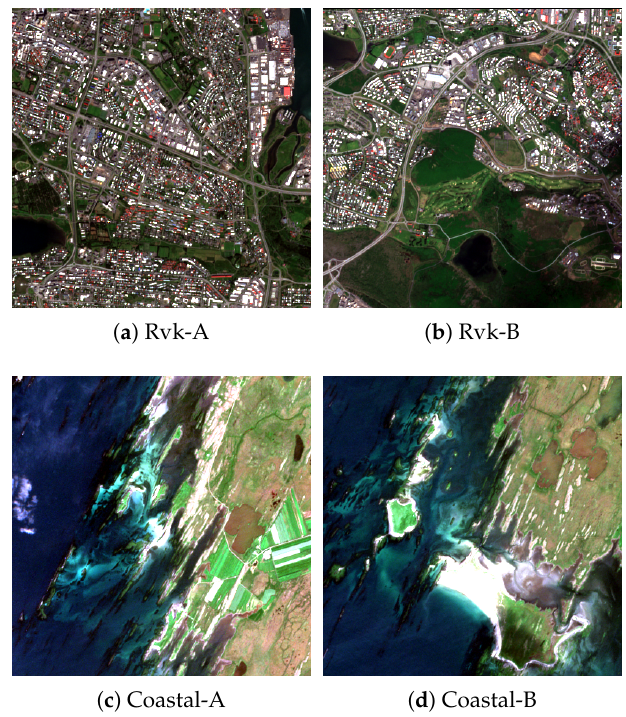
Figure 4. Datasets used for the super-resolution of 20 m bands. The datasets are displayed as RGB color images using bands B2, B3 and B4 as the red, green and blue channels,